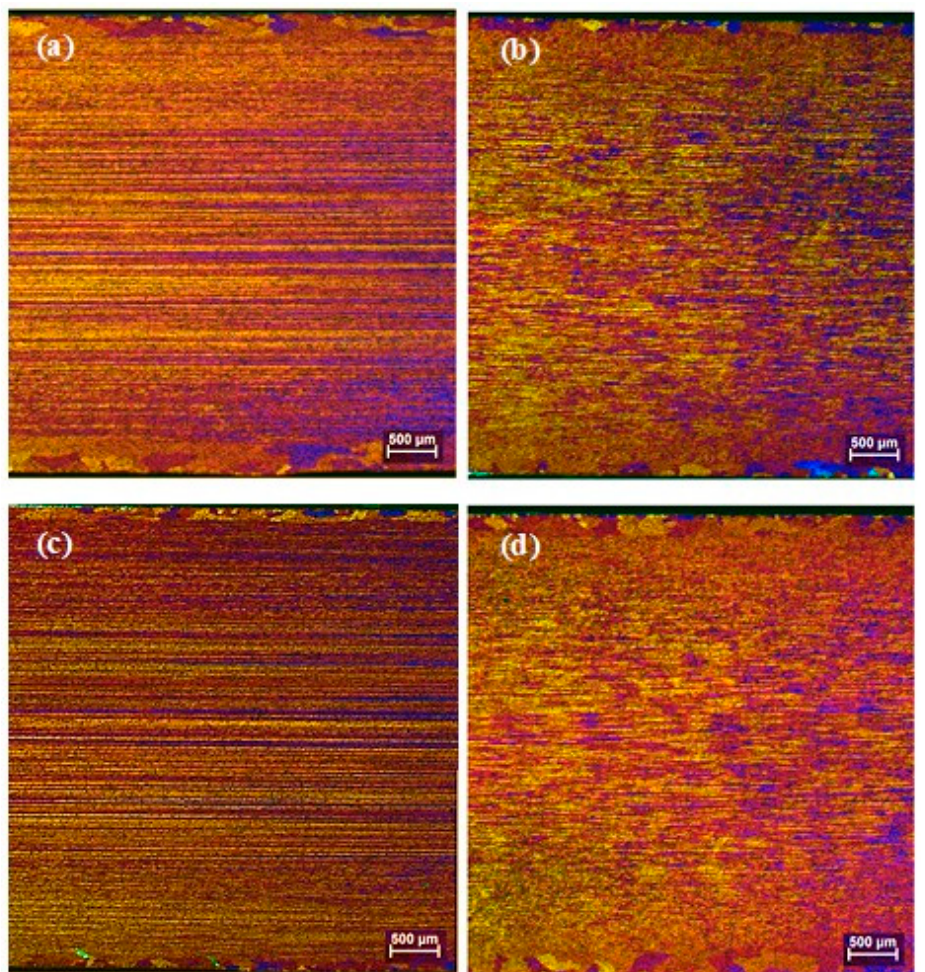
Figure6. OpticalmicrographsofformulatedBA-6111planksextrudedfrom, ( a , b )DC-GRinlongitudinal Figure 6. Optical micrographs of formulated BA-6111 planks extruded from, ( a, b ) DC-GR in and transverse sections, and ( c , d ) MC-DC in longitudinal and transverse longitudinal and transverse sections, and ( c, d ) MC-DC in longitudinal and transverse sections.